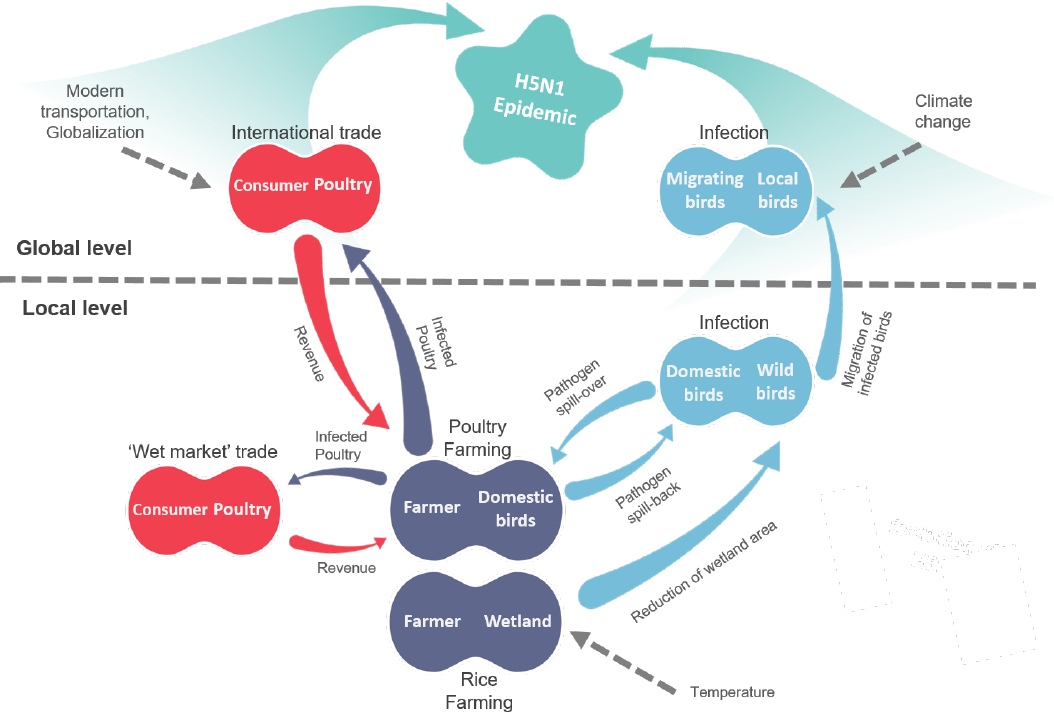
Figure A5: SE-AS representation of the configuration of the social-ecological (dark blue), ecological (light blue) and social action situations (red) hypothesized to influence the potential global outbreak of H5N1 avian